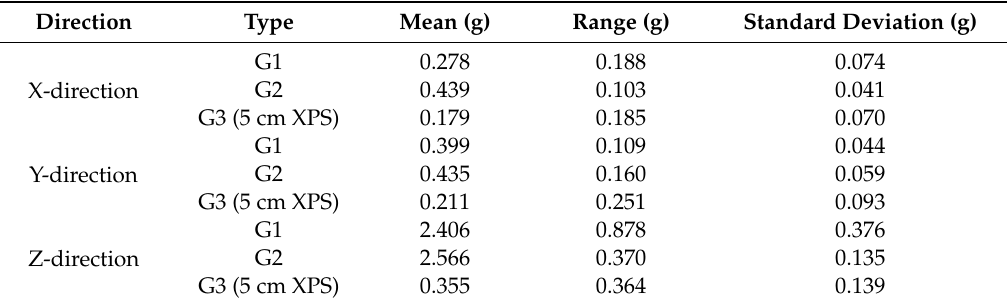
Table 5. The static results of the three test groups.